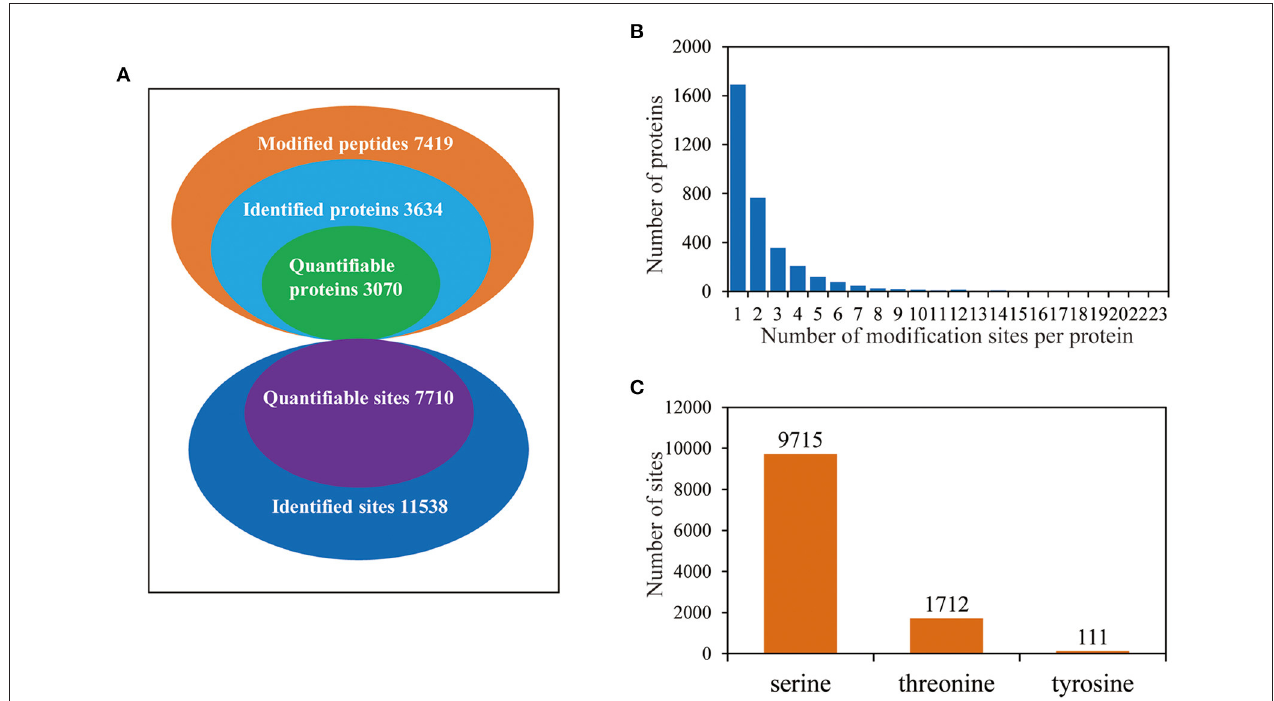
FIGURE 2 | The proteome-wide identification of phosphorylation proteins and sites in barley roots. (A) Summary of the phosphorylated proteins and sites identified and quantified; (B) peptide length distributions of phosphorylation profiles; (C) distribution patterns of phosphorylation occurring on serine, threonine, and tyrosine.